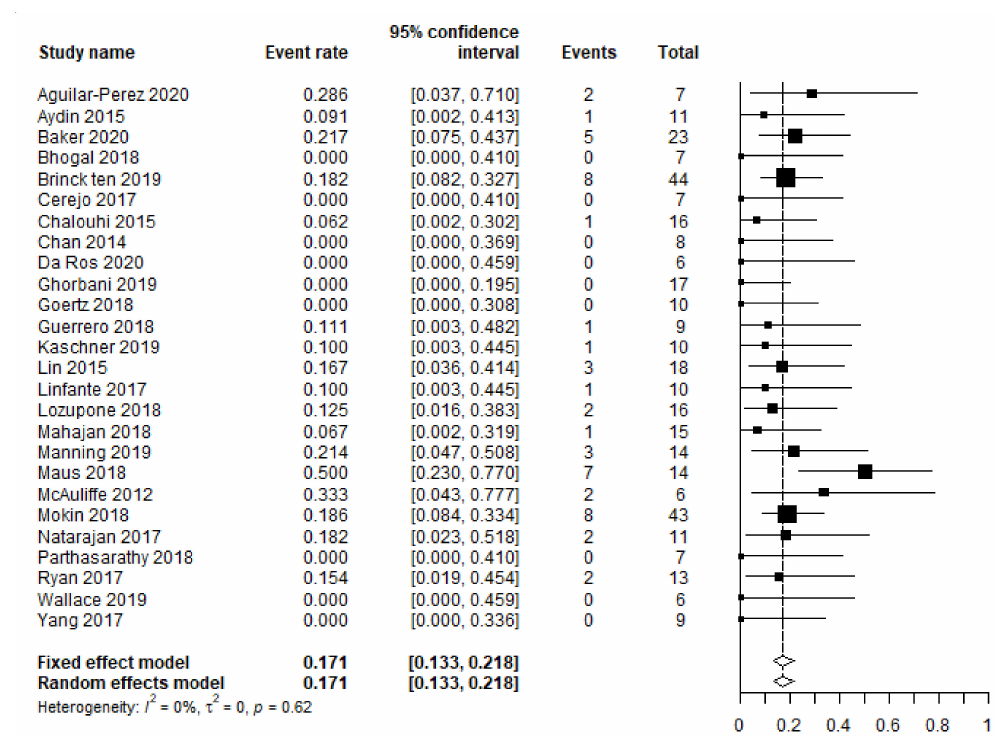
Figure 2. Meta-analysis of all-cause mortality. Based on 25 studies (274 patients), the pooled rate of complete aneurysm occlusion equaled 85.6% (95% CI 80.4–89.6 (Figure 3)) at the last available moment of follow-up. This rate was based only on the available data of survivors.